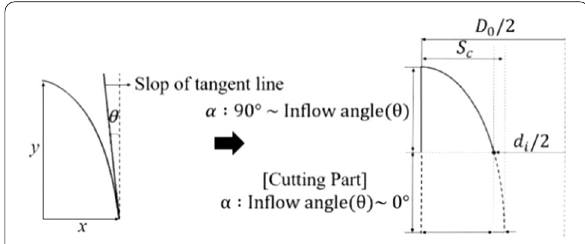
Figure 8 Calculation of tractrix die using slope of tangent line at a point Figure 10 3D modeling of the 1 st deep drawing